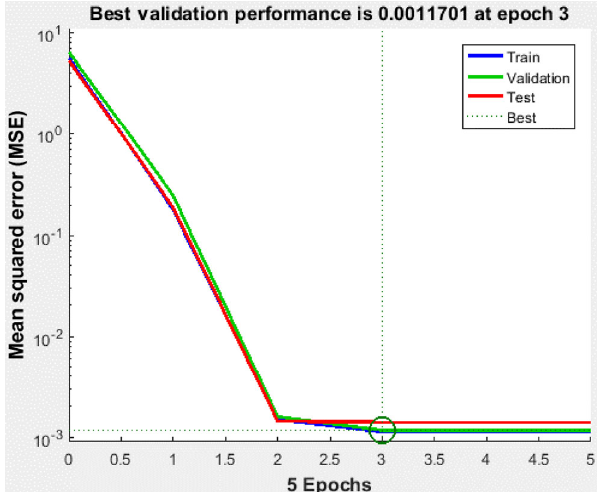
Fig. 19 Performance plot of optimized multi hidden layer ANN architecture (Network No. 64).